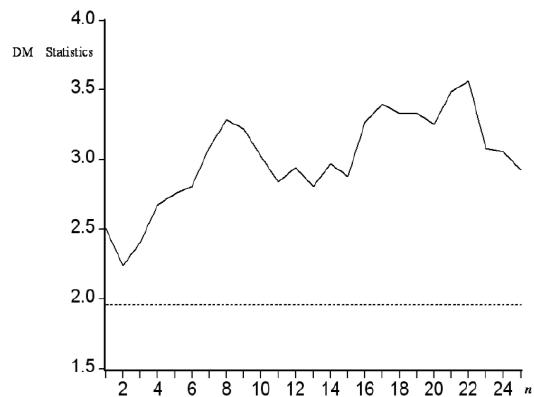
Figure 4. Statistic line of the augmented DM test between model A and model